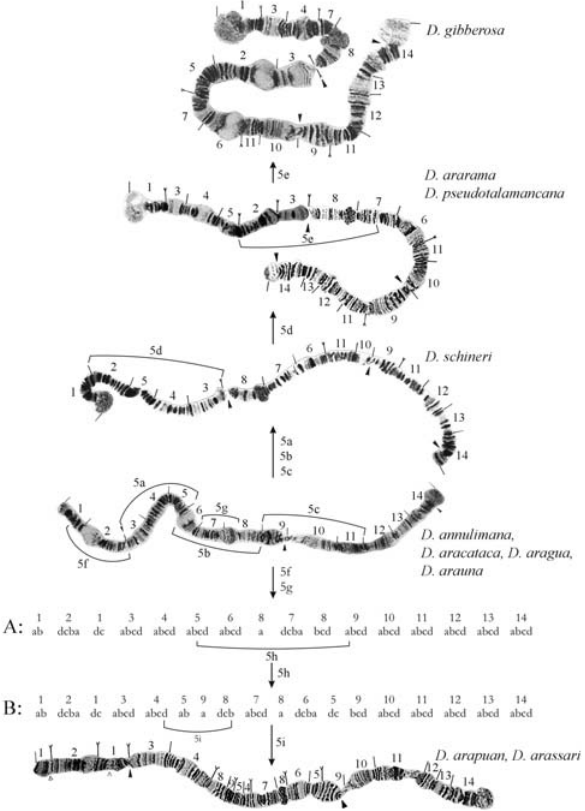
Figure 16 - Relationships among ten Drosophila species of the annulimana group based on the inversions found in chromosome 5. A: hy- pothetical sequence : homozygous inversions 5f and 5g. B: hypothetical sequence: homozygous inversion 5h. Subdivisions (abcd) have no corre- spondence in the photographic map and were included to facilitate under-